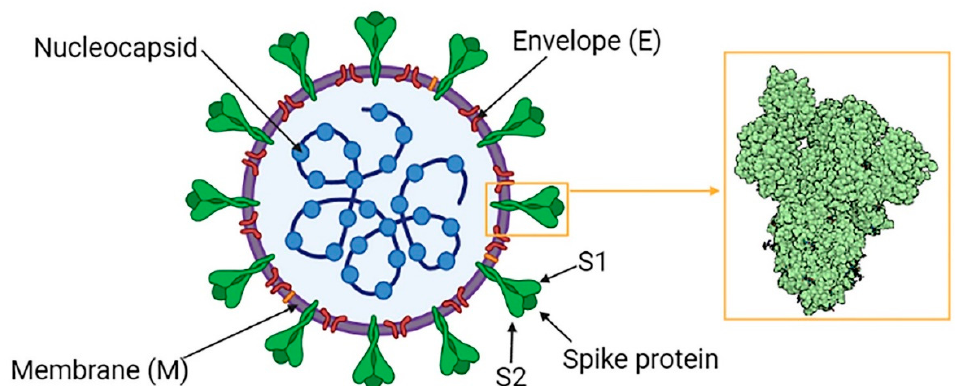
Figure 2. SARS-CoV 2 Structure. In the yellow box the structure-based design of prefusion-stabilized SARS-CoV-2 spikes. Created in Biorender.com.